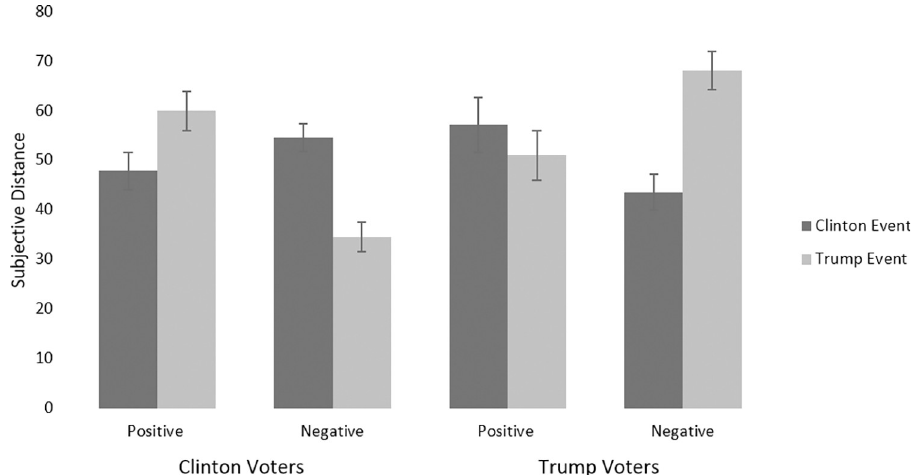
Fig 1. Relationship between voter affiliation, candidate, and event valence on subjective temporal distance. Bars represent standard errors.